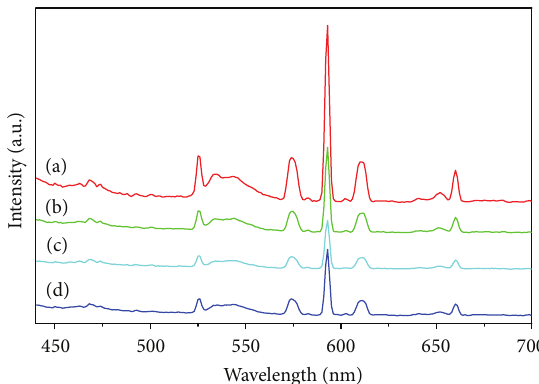
Figure 5: Photoluminescence emission spectra of different concentrations of Eu 3+ doped Yb 2 O 3 : (a) 1% Eu 3+ , (b) 2% Eu 3+ , (c) 5% Eu 3+ , and (d) 10% Eu 3+ by excitation at 395